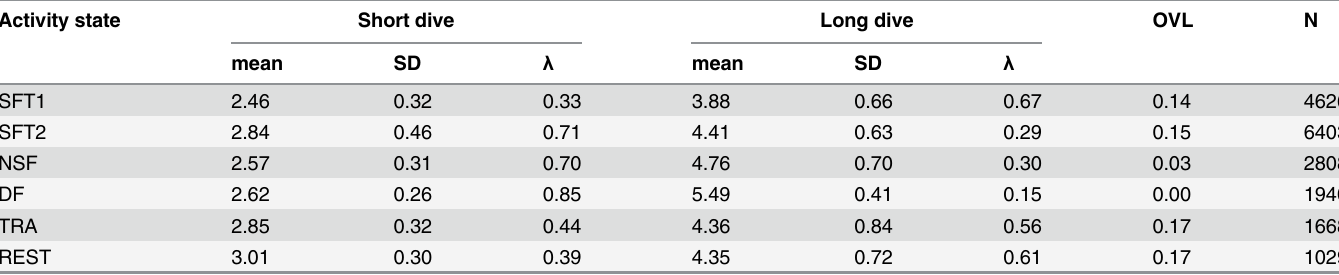
The mean dive durations (logged IBI (sec)), SDs and relative occurrences ( λ ) of the two dive types (short dive and long dive) identi fi ed for each activity (SFT1 = surface feeding tactic I, SFT2 = surface feeding tactic II, NSF = near-surface foraging, DF = deep foraging, TRA = traveling, REST = resting). Observe that λ constitutes only one parameter in the model, the second value of λ was obtained from 1- λ . OVL = Overlapping coef fi